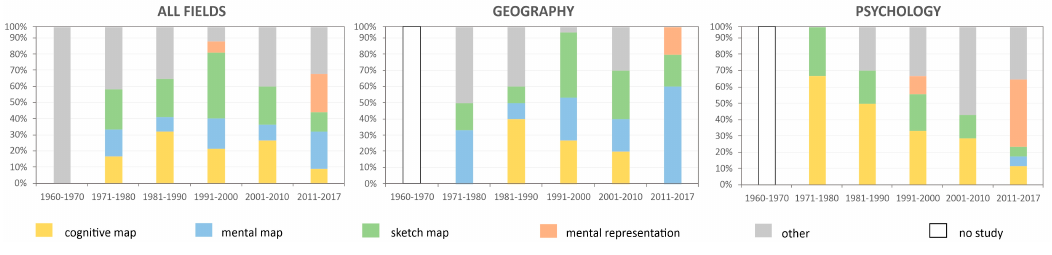
Figure 2. Changing